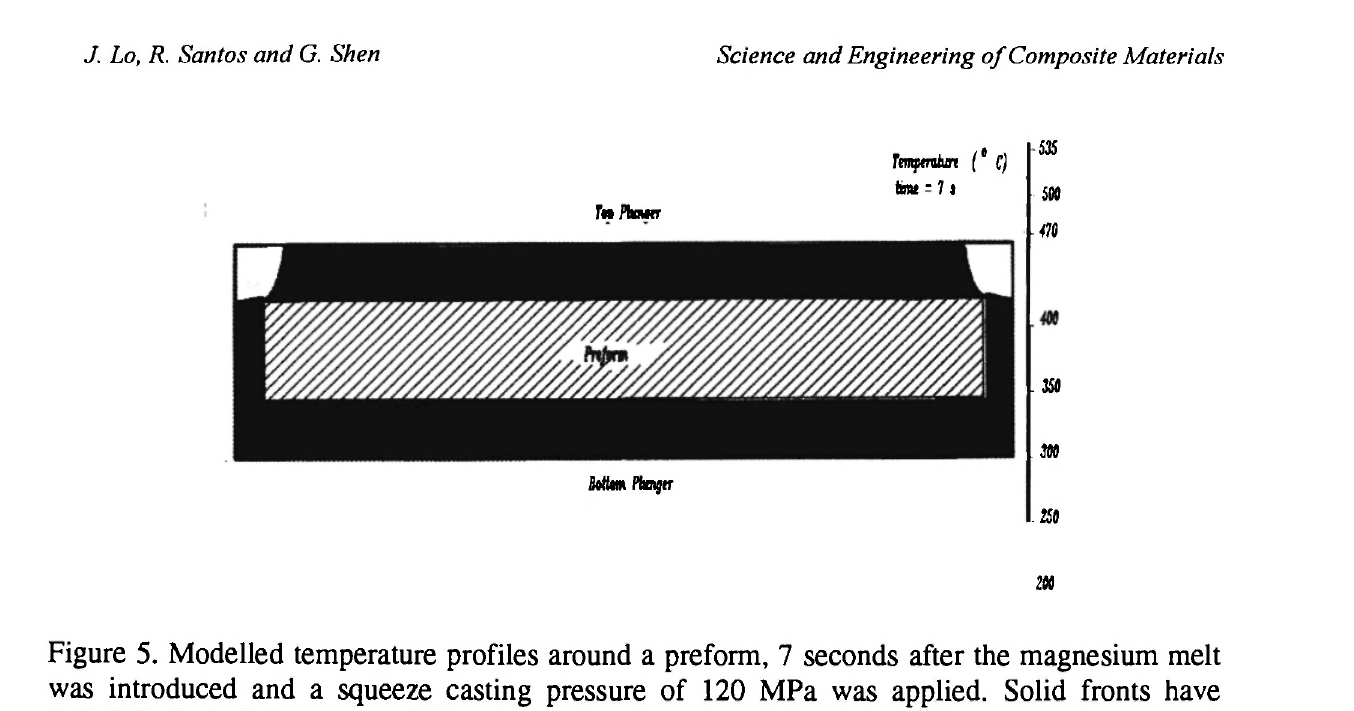
Figure 5. Modelled temperature profiles around a preform, 7 seconds after the magnesium melt was introduced and a squeeze casting pressure of 120 MPa was applied. Solid fronts have definitely locked the top portion of the preform in